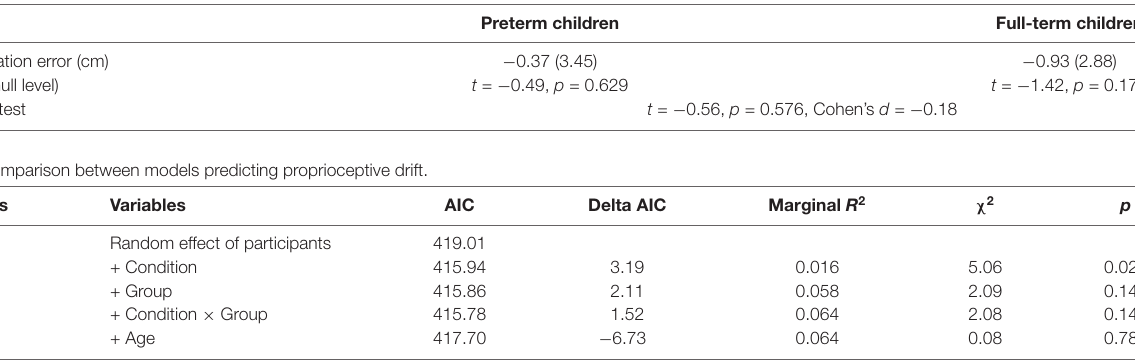
TABLE 3 | Simple t -test comparing baseline pointing score with the real position of the hand (baseline estimation error in cm) and independent t -test testing the difference between groups.